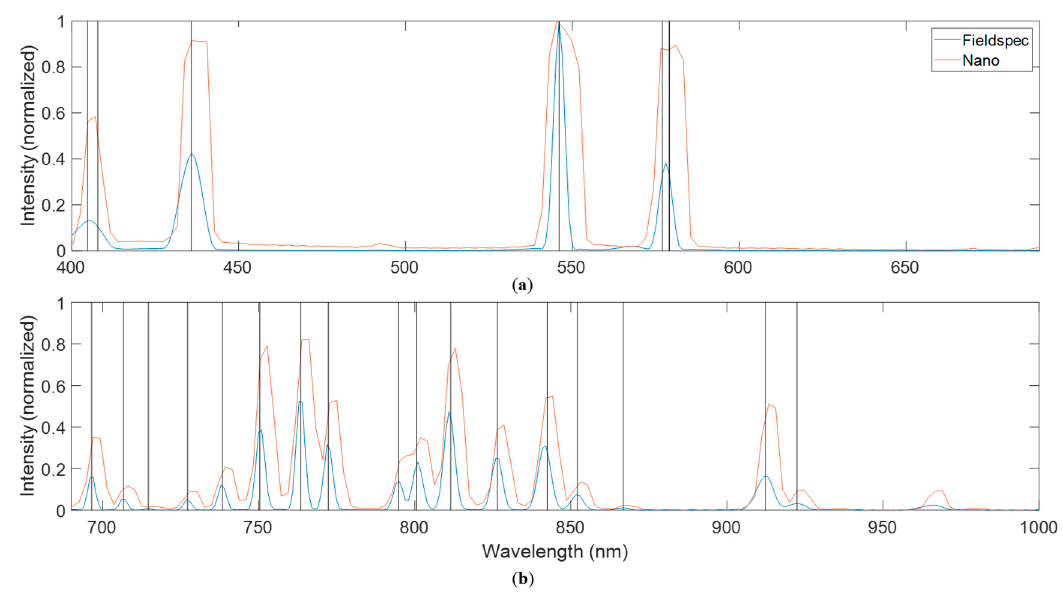
Figure 6. Normalized intensity comparison between Hg lamp ( a ) and Ar lamp ( b ) emission lines (vertical black lines, see Table 2 for reference values) and recorded spectra with the ASD Fieldspec-4 (blue curve) and the Nano-Hyperspec sensor (orange).